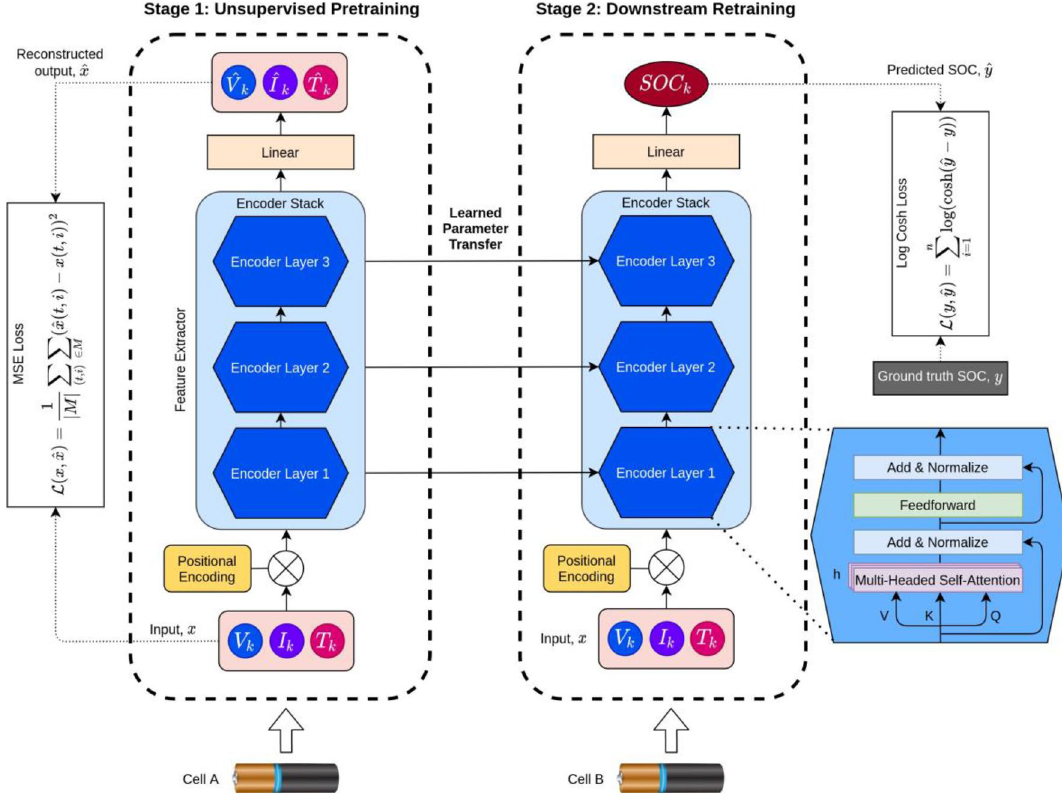
Figure 6. Framework and architecture of the proposed transformer